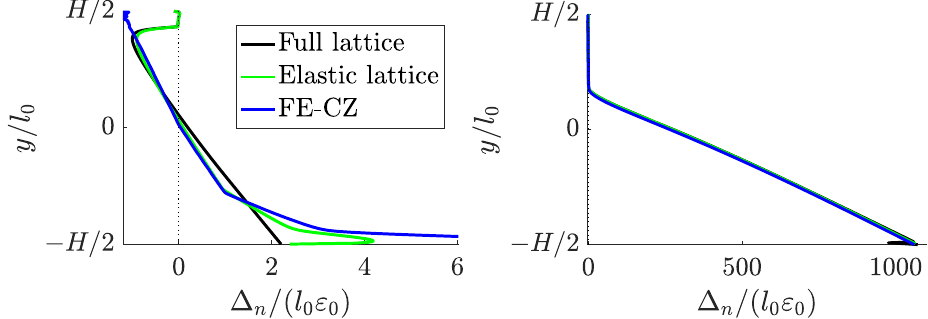
Figure 7. Normalized opening profiles for fixed pre-peak loading force F/ ( E loading force F/ ( E 0 A 0 ε 0 ) = 14 (right) computed for the ductile material setting.